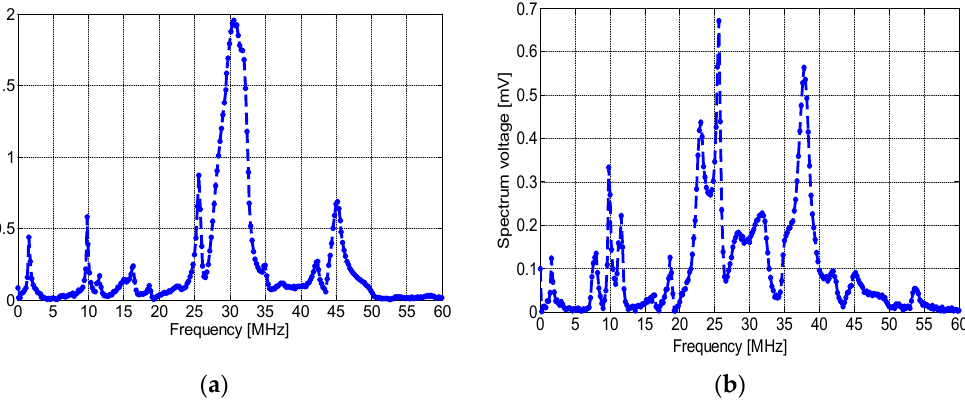
Figure 15. Frequency spectra detected by the: ( a ) non-spiral and ( b ) meander, inductive sensors when placed at P3.